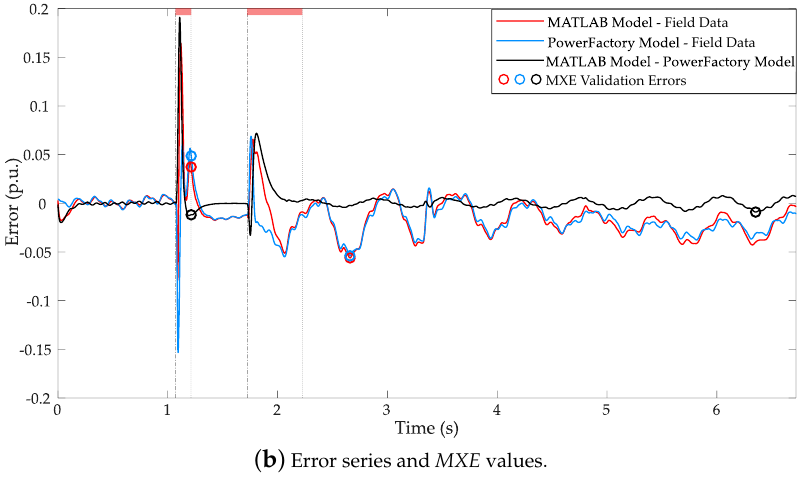
Figure 11. Active power in Test Case 2: u = 0.25 pu, t = 625 ms.